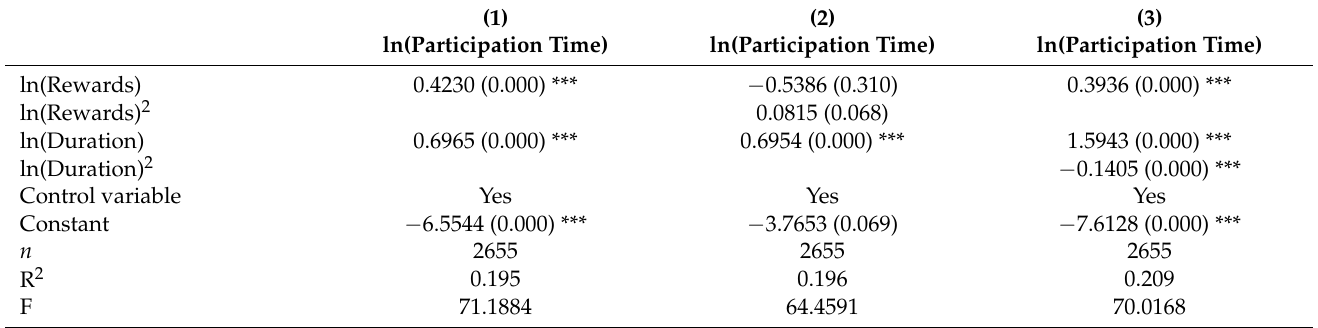
Table 6. Regression results of Equation